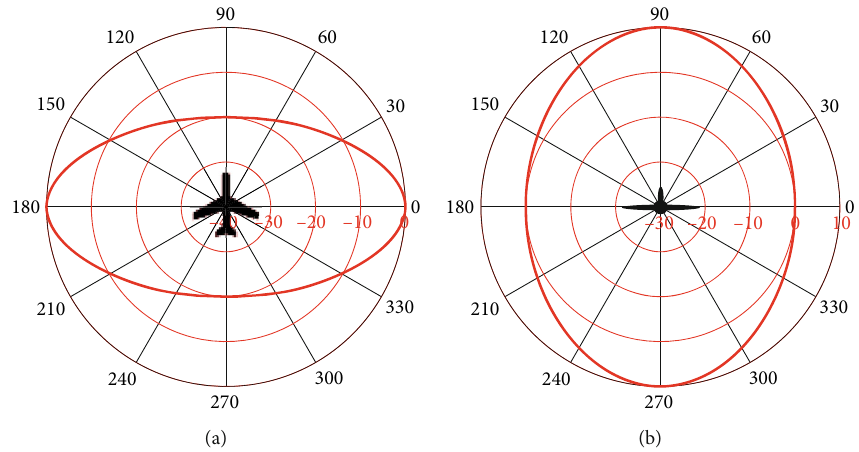
Figure 5: Horizontal RCS patterns (a) and vertical RCS patterns (b) for UAV. The RCS unit is in